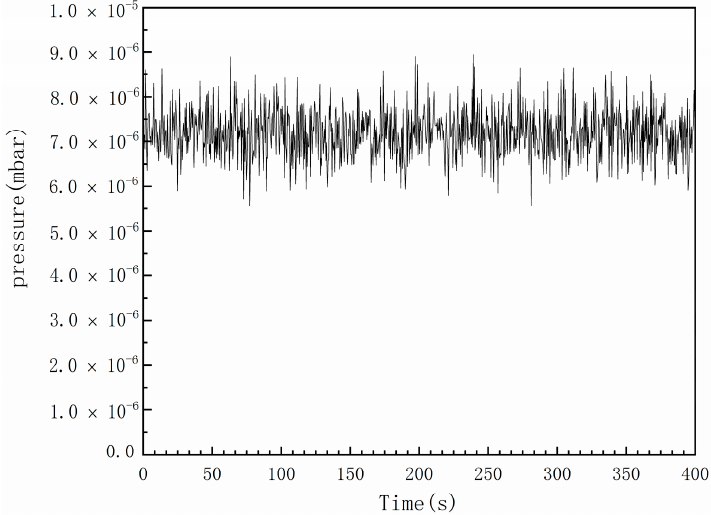
Figure 4. The change in the average pressure of the bending-magnet area of the vacuum chamber over time during the 400 s long-pulse.